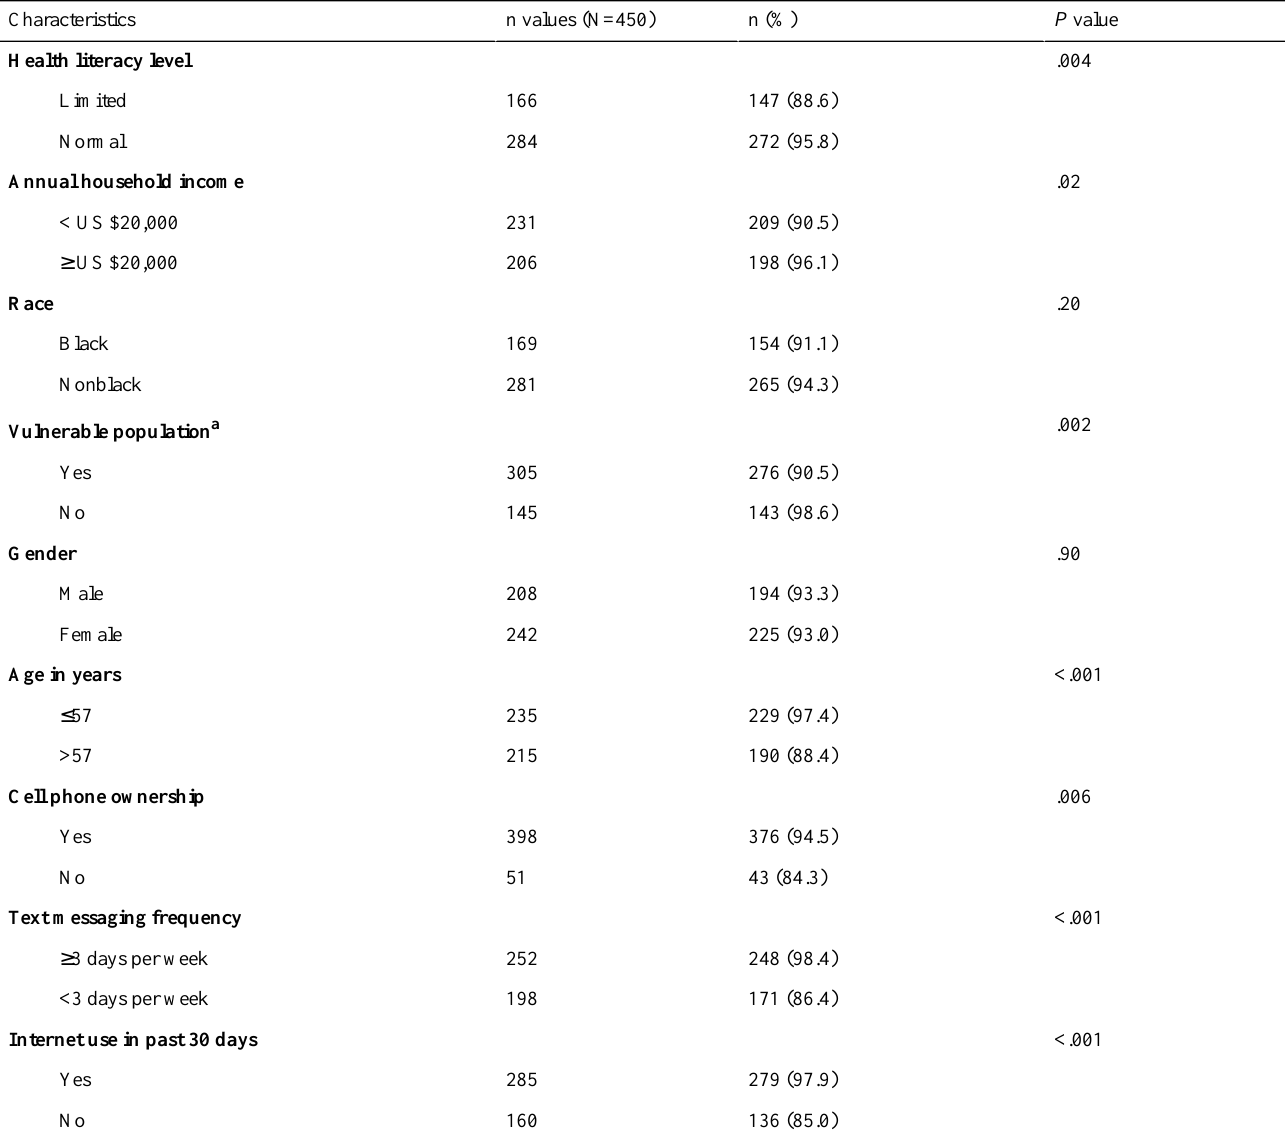
Table 3. Proportion of participants completing the mPATH mHealth program without any